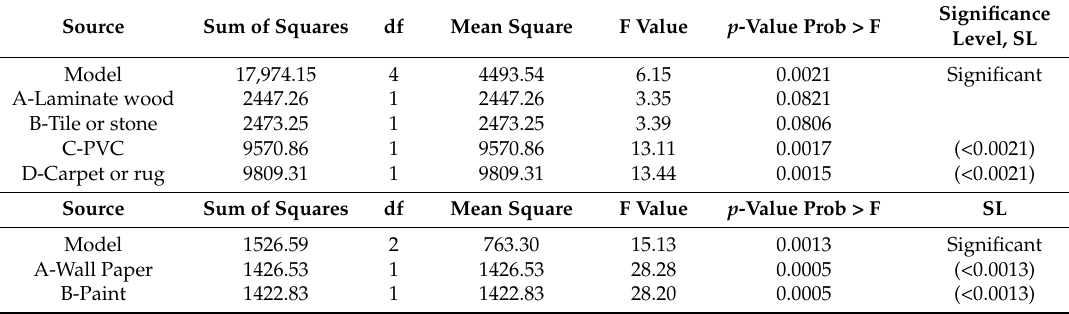
Table 4. Summary of ANOVA for the condensation on the window pane (WCM) model